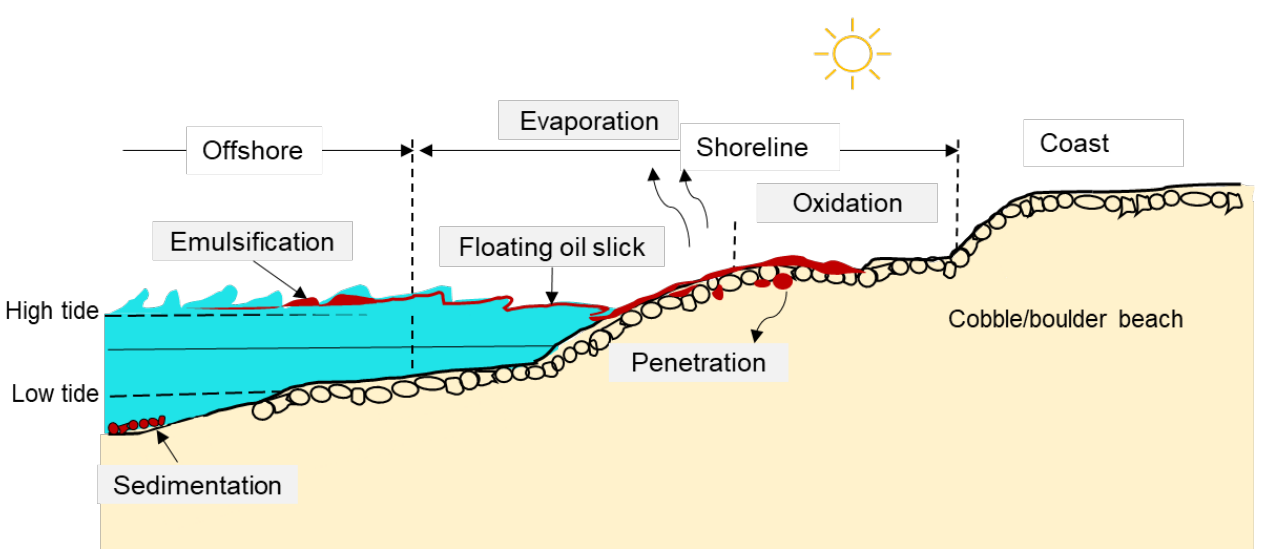
Figure 2. Example of the oil fate on shorelines.